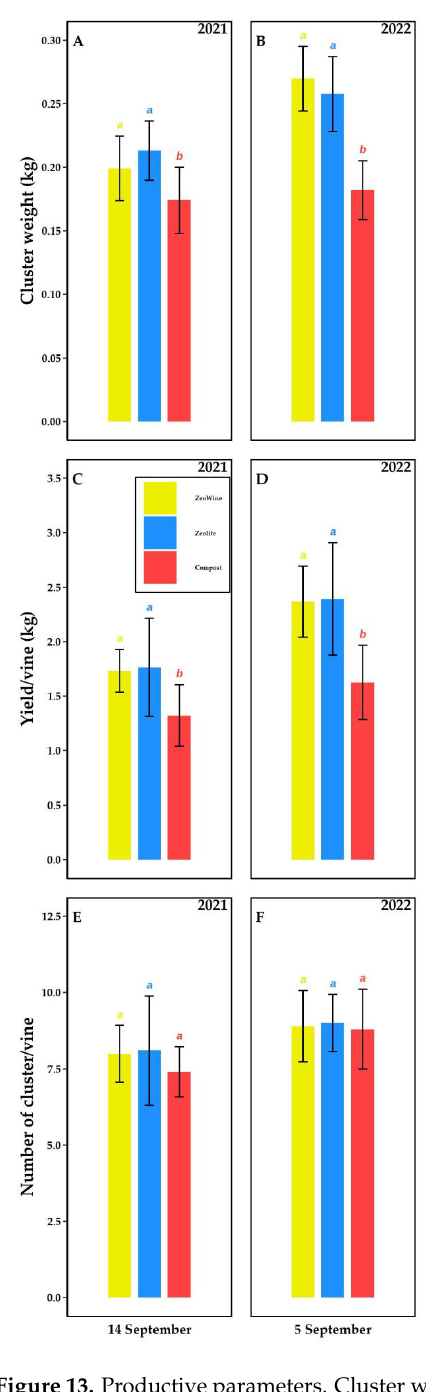
Figure 13. Productive parameters. Cluster weight, yield per vine, and the number of clusters per vine (2021 and 2022 seasons, ( A )–( F )). Measurements were at the harvest stage (14 September 2021 and 5 September 2022). Data (mean ± SE, n = 10) were subjected to one-way ANOVA. The bars represent the standard deviation. Different letters indicate significant differences between Zeowine, Zeolite, and Compost (LSD test, p ≤